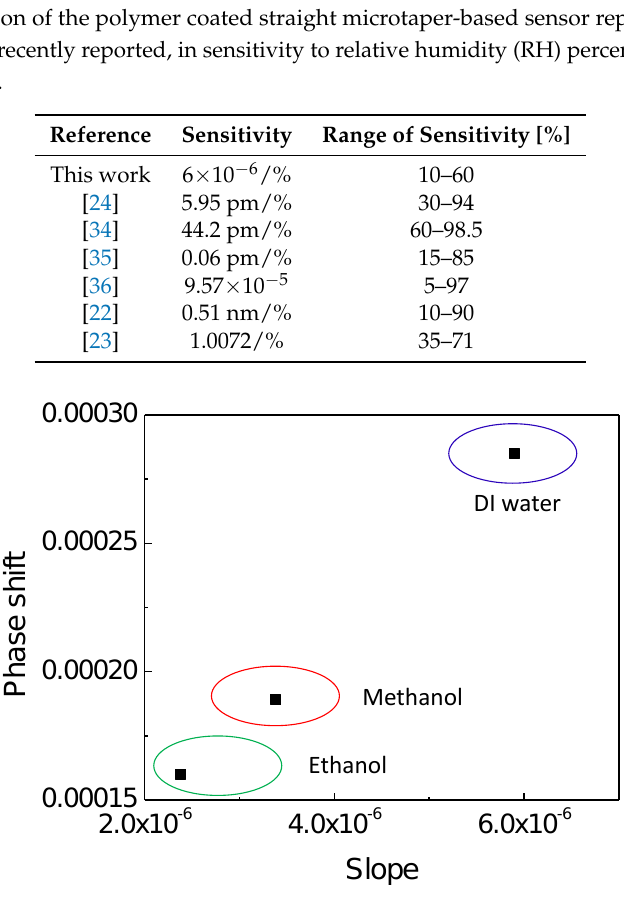
Figure 6. Analyte calibration plot in principal component space of phase shift versus